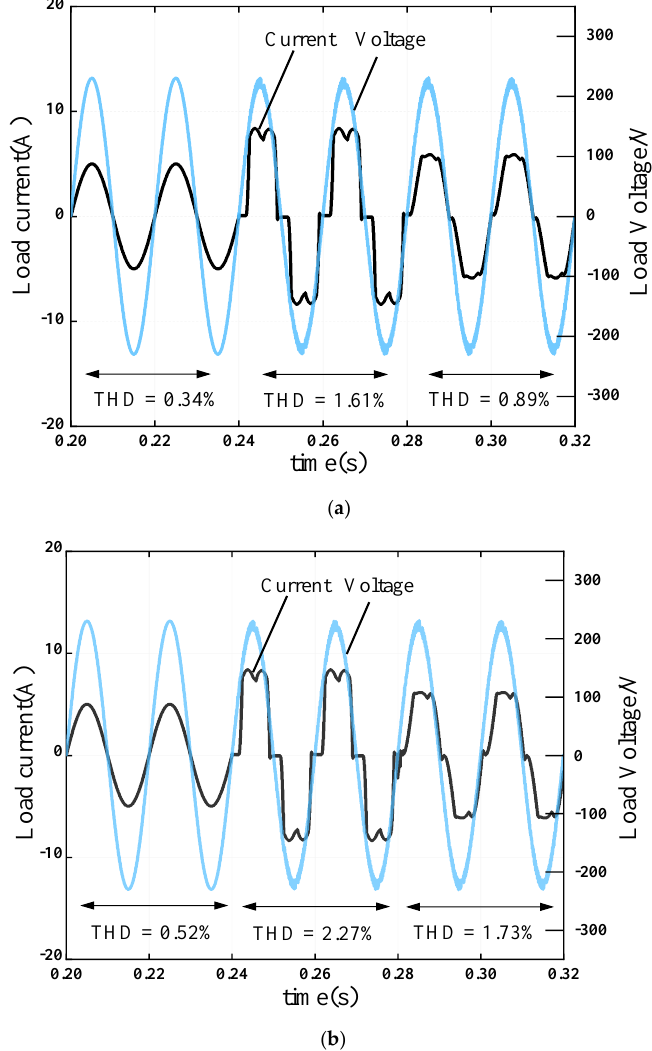
Figure 13. Waveforms of voltage and current under different loads. ( a ) Waveforms of voltage and current at different loads in the improved LADRC; ( b ) waveforms of voltage and current at different loads in the classical LADRC.